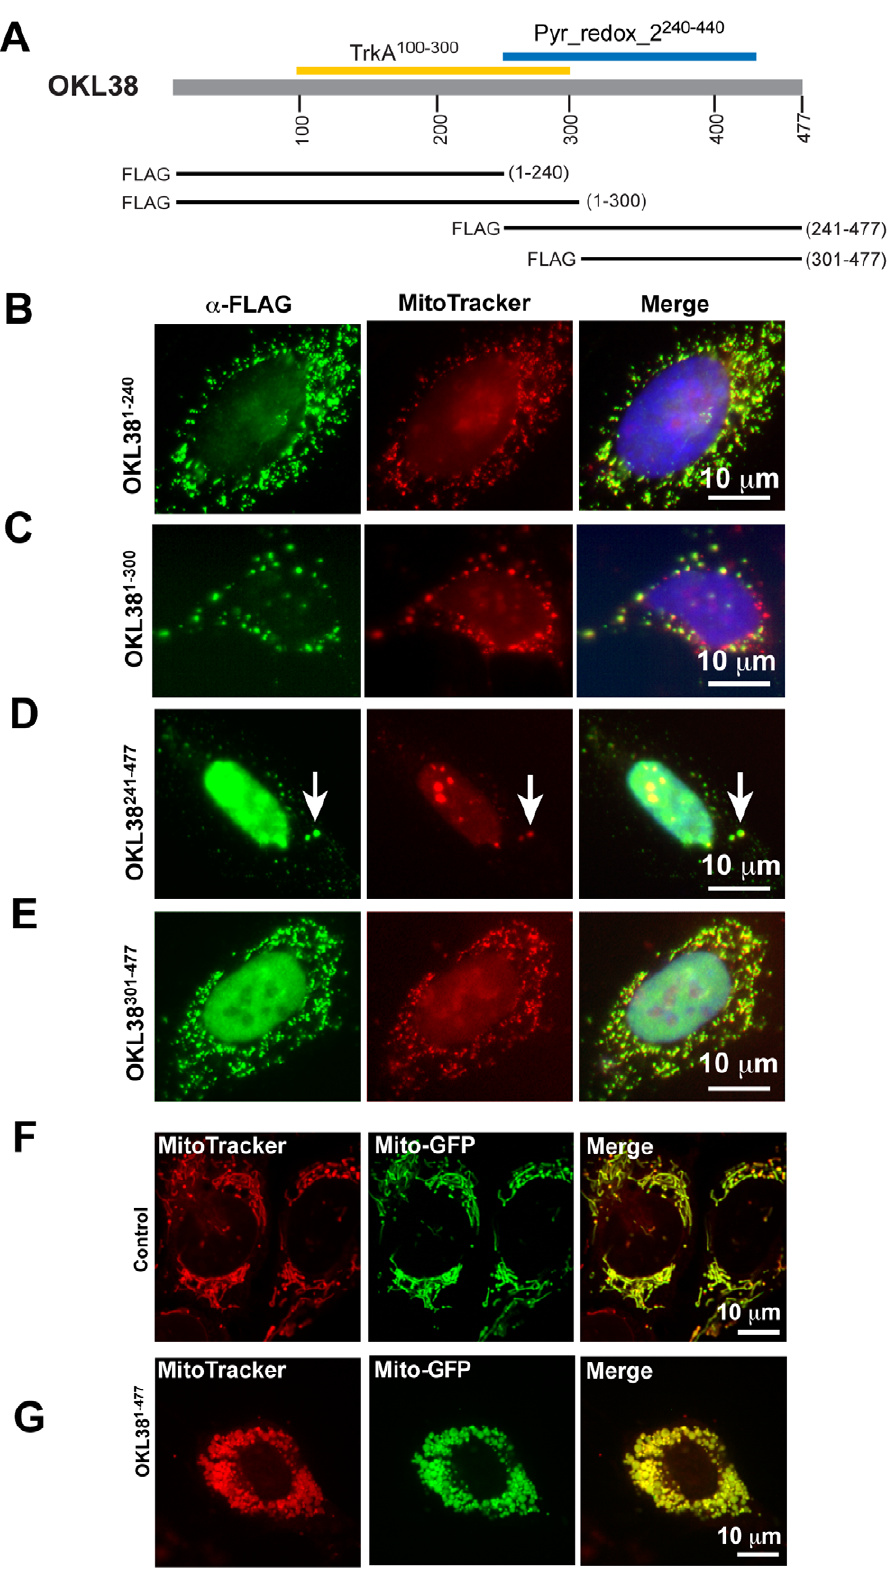
Figure 4. Subcellular localization of OKL38 truncation derivatives. ( A ) Schematic drawing of the OKL38 domain structure and FLAG-OKL38 truncations used to analyze subcellular distribution. (B–C) Preferential mitochondrial localization of FLAG-OKL38 1–240 (B) and FLAG-OKL38 1–300 (C). (D– E) Nuclear and mitochondrial localization of FLAG-OKL38 241–477 (D, arrows denote mitochondria) and FLAG-OKL38 301–477 (E). Also see figure S4 for more examples of subcellular localization of FLAG-OKL38 truncations. (F–G) The morphology of mitochondria in live cells was detected using a GFP-